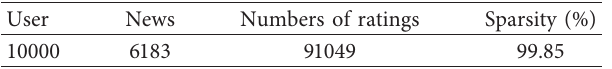
Table 3: Data sparse